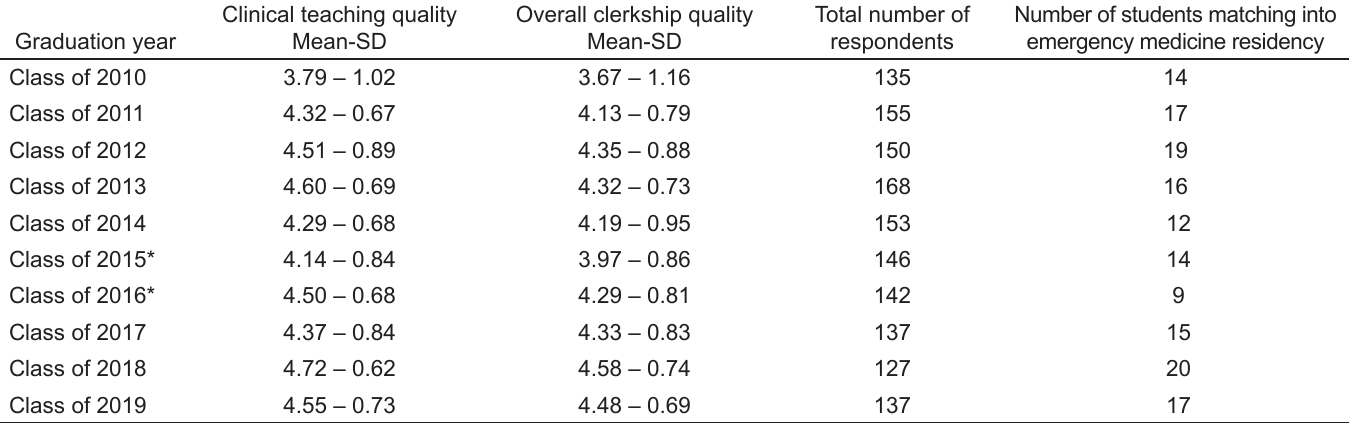
*There was a loss of the teaching attending at the tertiary referral university adult hospital for 12 months for the Class of 2015 and four months for the Class of